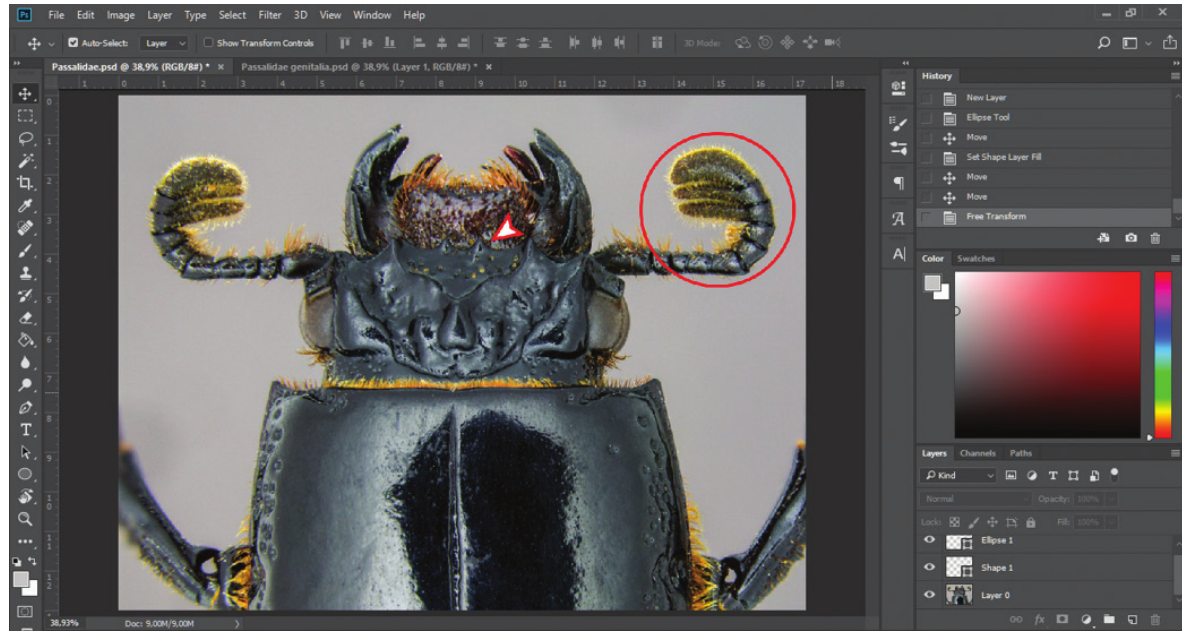
Figure 21. Image containing evidence